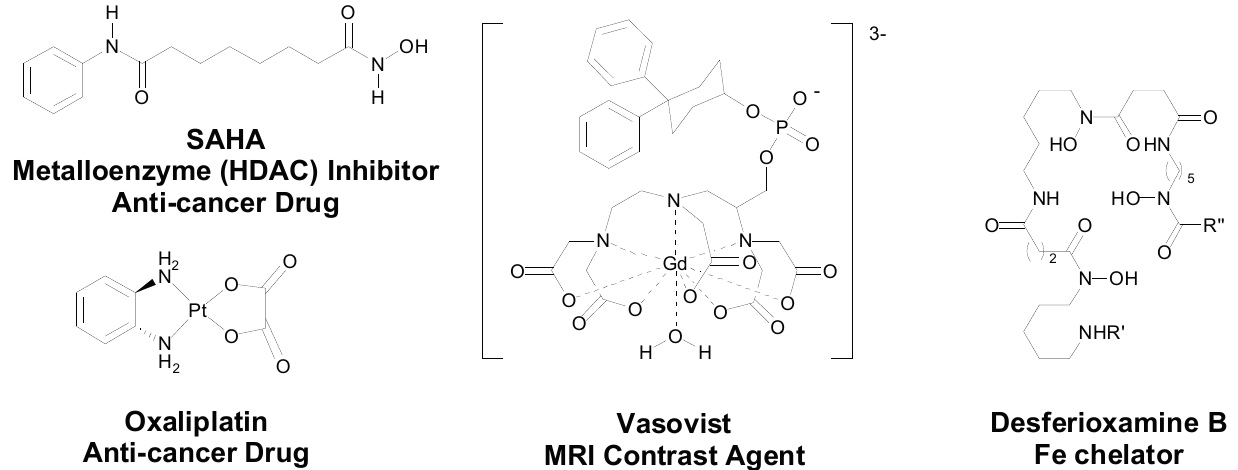
Figure 1. Structures of representative examples of a metal-based therapeutic and diagnostic, metal chelator and metalloprotein inhibitor